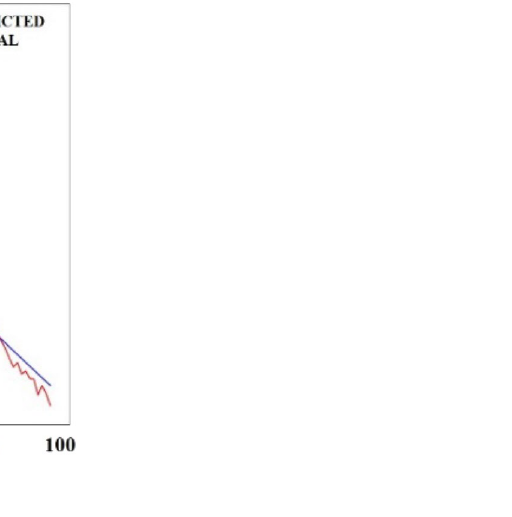
Figure 13. Test result in dataset